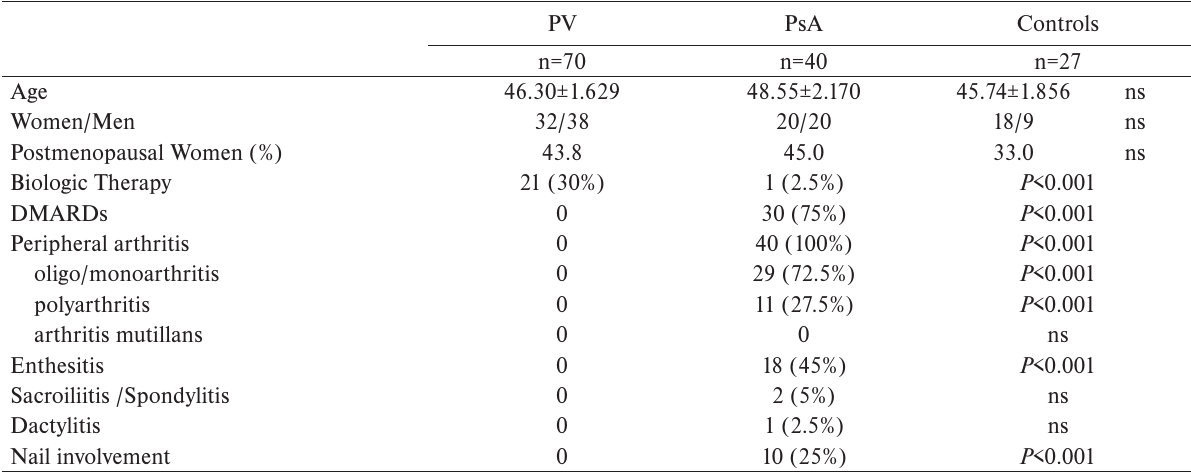
Table 1. Demographic Data: Psoriasis Vulgaris (PV), Psoriatic Arthritis (PsA) and Healthy Individuals (Controls).